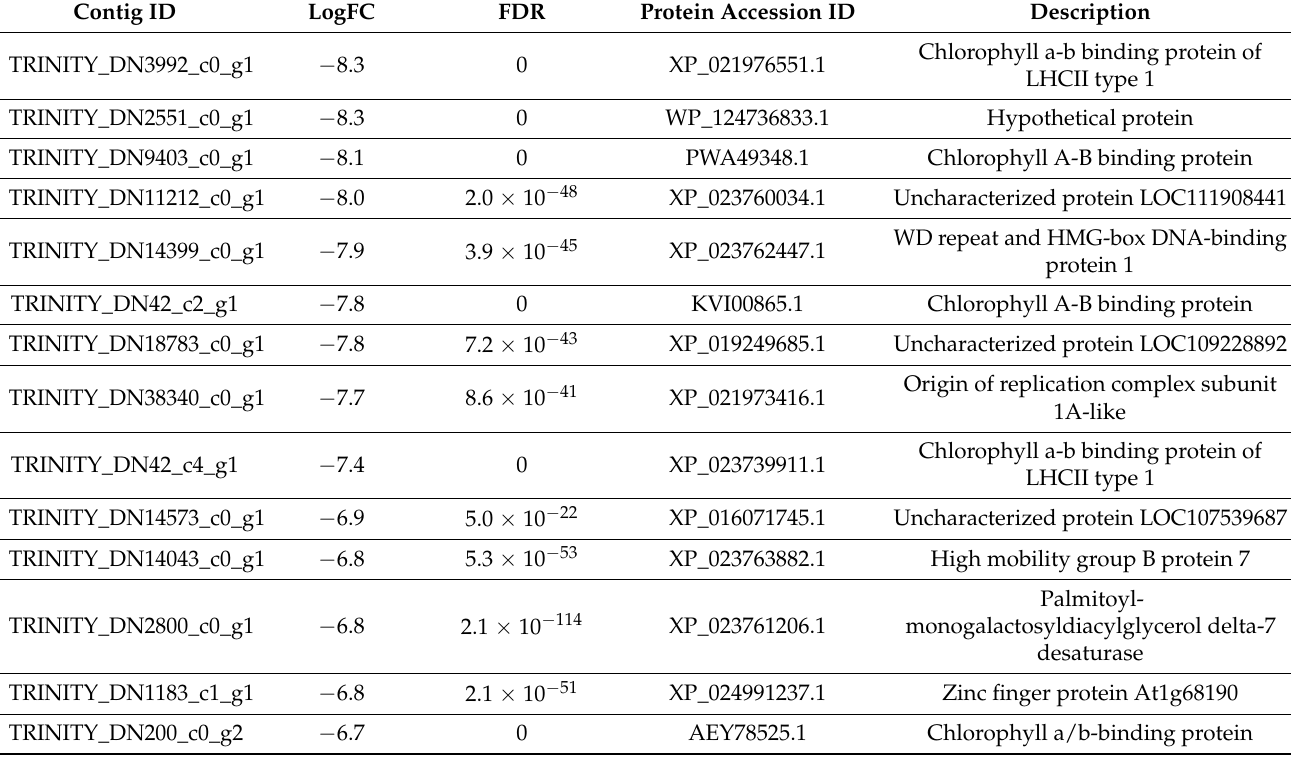
Table 3. The gene list of the top 20 downregulated genes in TNRG vs. TNRC. De novo transcriptome analysis followed by DEG analysis were performed by Trinity and edgeR softwaren with the same cDNA libraries used in Table 2. A total of 3852 genes were downregulated significantly over − 4 FC in TNRG than TNRC (FDR < 0.05). This table lists the top 20 genes of the downregulated